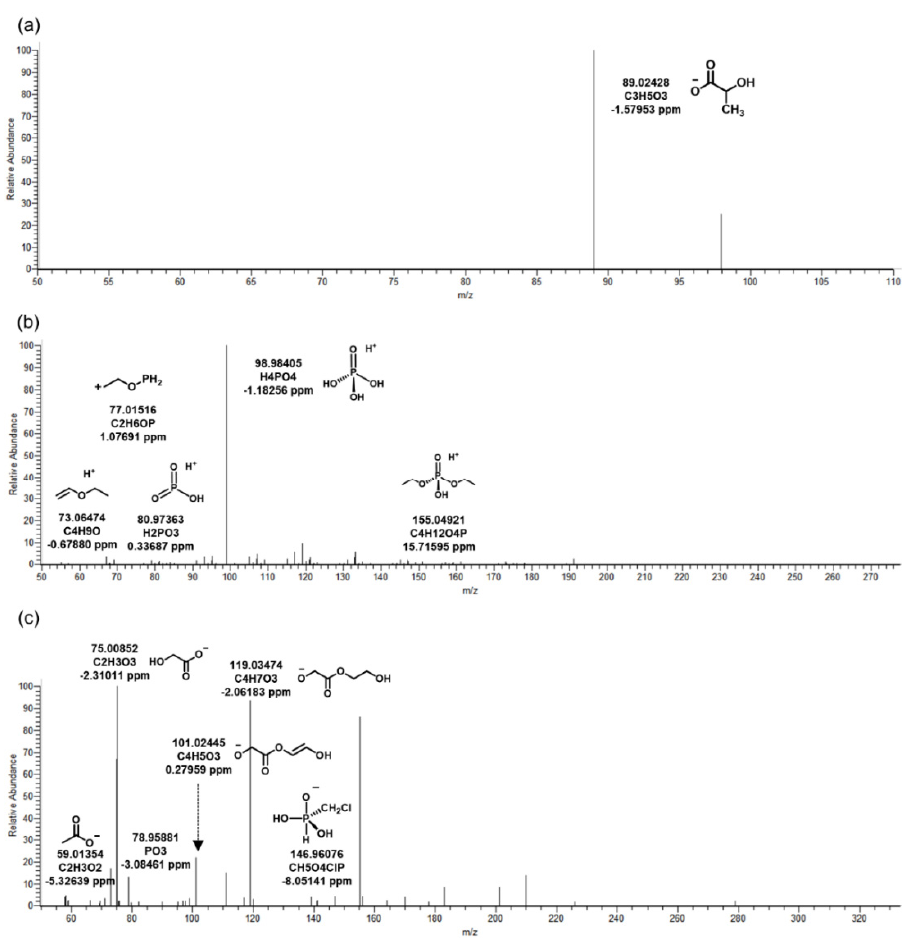
Figure 3. MS/MS fragments of tris (1-chloro-2-propyl) phosphate in biological reactor of wastewater treatment plant. The biotransformation products: ( a ) TC_90, ( b ) TC_249, ( c ) TC_304.